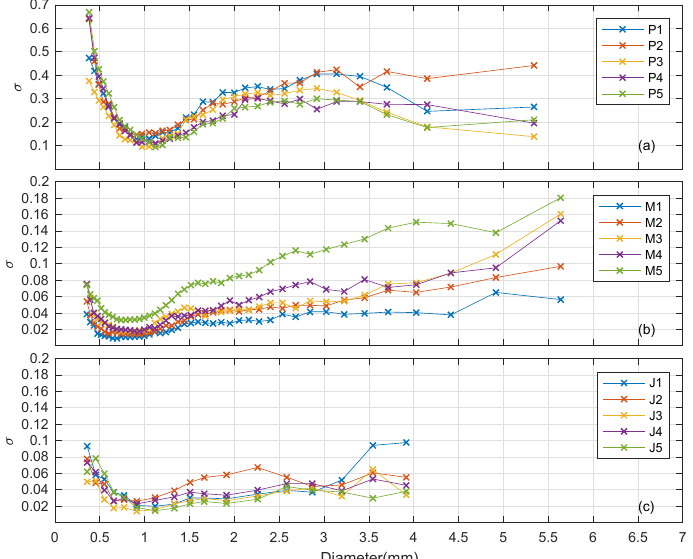
Figure 11. The measurement noise ( σ (cid:2897)(cid:2900)(cid:2897) ) of the logarithmic value of drop number concentration as a function of raindrop size for ( a ) POSSs, ( b ) MRRs and ( c ) JWDs. Both measurement noises of POSSs and MRRs increased with increasing raindrop size from turbulent motion that can mask the true terminal velocity of the drops. The POSSs have the lowest measurement noise at the raindrop size of 1.0 mm. The lowest measurement noise of JWDs exists over the size ranges of 1.0 to 2.0 mm. The P1 and P2 have higher σ (cid:2897)(cid:2900)(cid:2897) between raindrop sizes of 2.5 and 4.0 mm compared with other POSSs, and M5 has a higher σ (cid:2897)(cid:2900)(cid:2897) for all sizes compared with other MRRs. J2 has a higher σ (cid:2897)(cid:2900)(cid:2897) between 1.5 and 3.0 mm compared with other JWDs. These features of relatively higher σ (cid:2897)(cid:2900)(cid:2897) are consistent with higher values of σ (cid:2897)(cid:2900)(cid:2897) of R and Z as discussed in Figure 10 and Section 4.2.1.